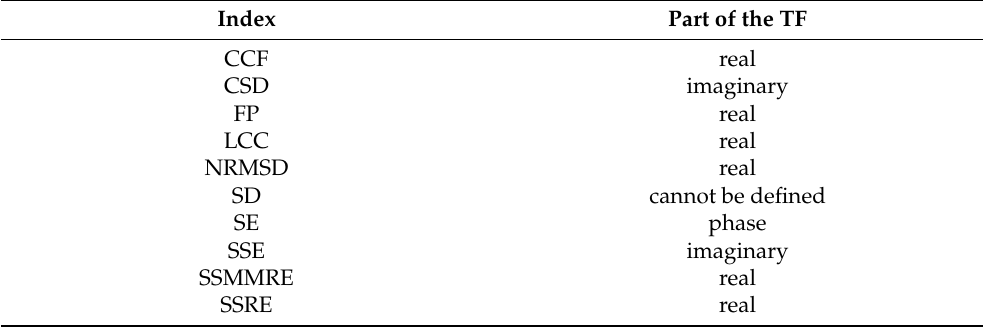
Table 1. The part of the TF whose features extracted from its data are most sensitive to the occurrence of the DSV fault.